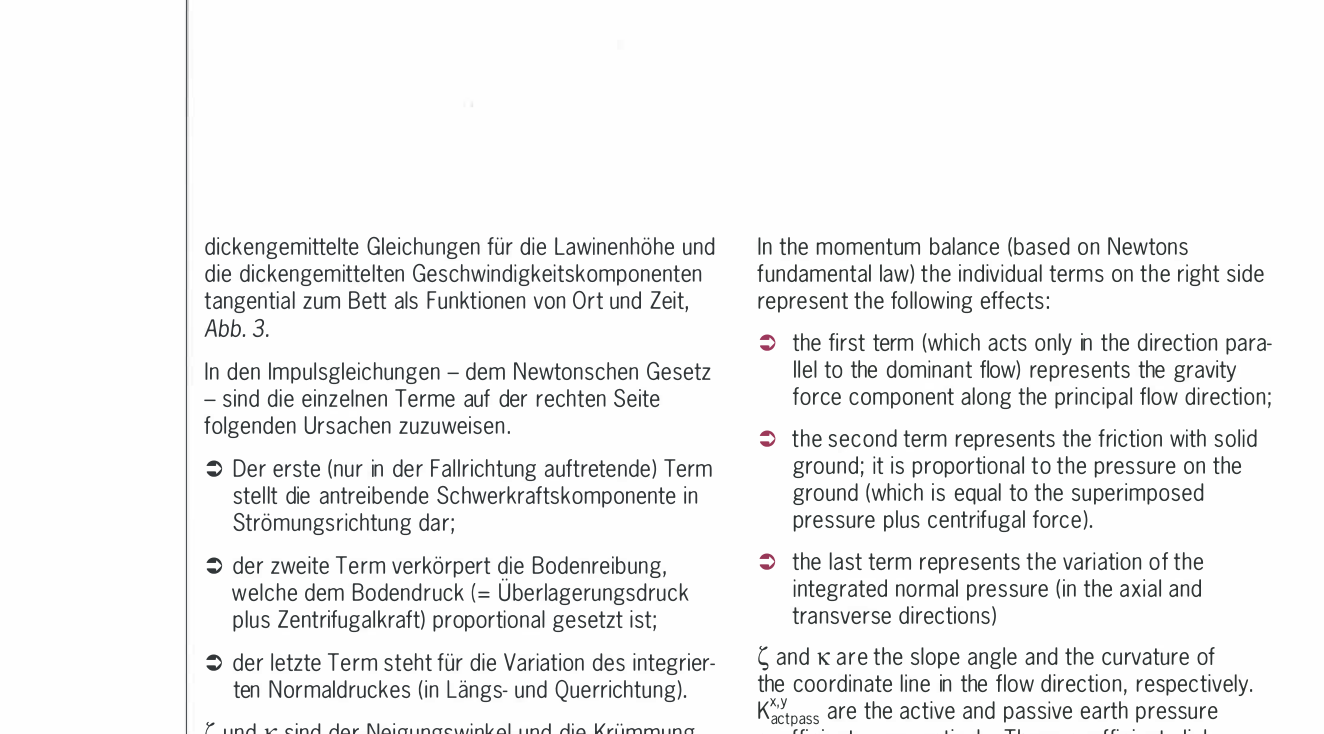
Abb. 3: (a} Skizze des krummlinigen Koordinatensystems, 1;, bezeichnet den Neigungs­ winkel der Erzeugenden, b(x, y} gibt den orthogonalen Abstand des Lawinenbettes von der Zylinderfliiche. (b) Die Gleichungen (1}, (2}, (3} stellen die Massenbilanz